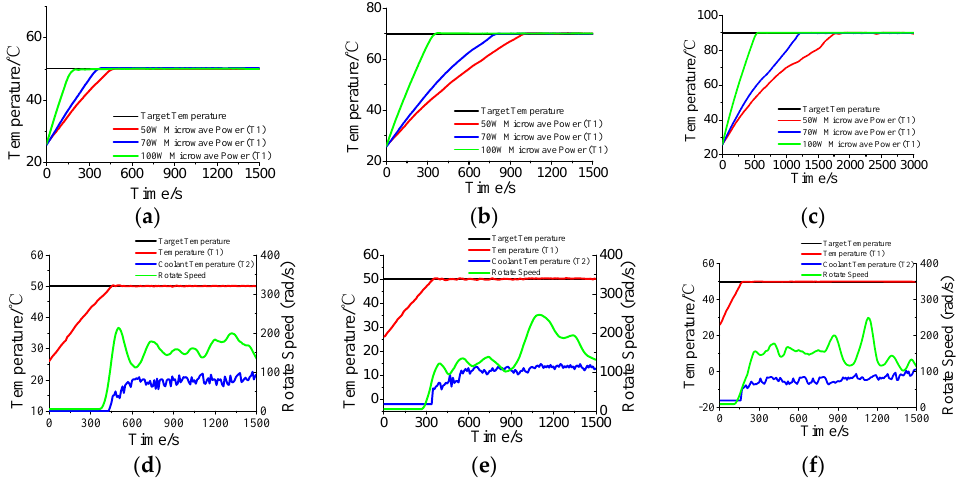
Figure 6. The temperature of water under different microwave irradiation power: ( a – c ) control temperature under 50, 70, and 100 W; ( d – f ) the temperature was controlled to 50 °C under 50, 70, and 100 W.